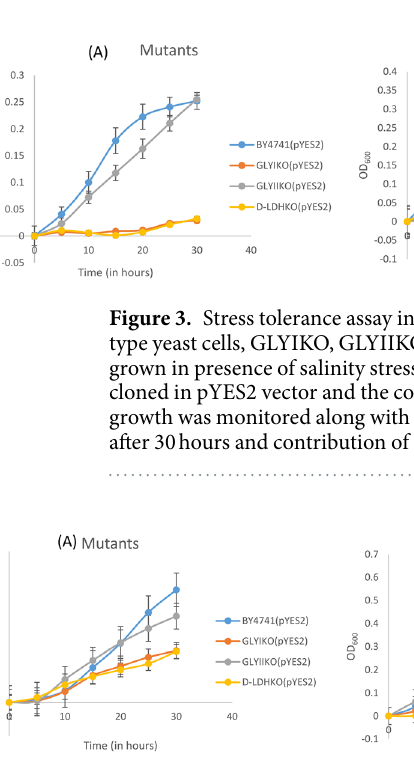
Figure 4. Heterologous expression of MG detoxifying enzymes in yeast mutants confers oxidative stress tolerance: BY4741 wild type yeast cells, GLYIKO, GLYIIKO and D-LDHKO mutant yeast cells containing empty vector pYES2 were grown in presence of oxidative stress ( A ). These mutant cells were transformed with their respective mutant genes cloned in pYES2 vector and the complemented yeast cells were grown in presence of oxidative stress and their growth was monitored along with wild type BY4741 cells ( B ). MG levels were estimated in all of these samples after 30 hours and contribution of these genes in detoxification of MG was compared ( C